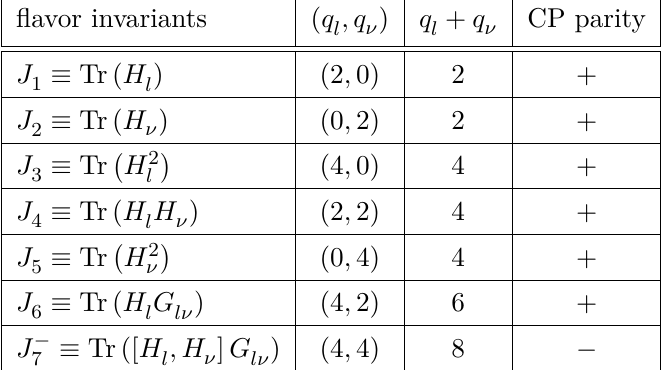
and q denote the degree of M and M , ν ν l l